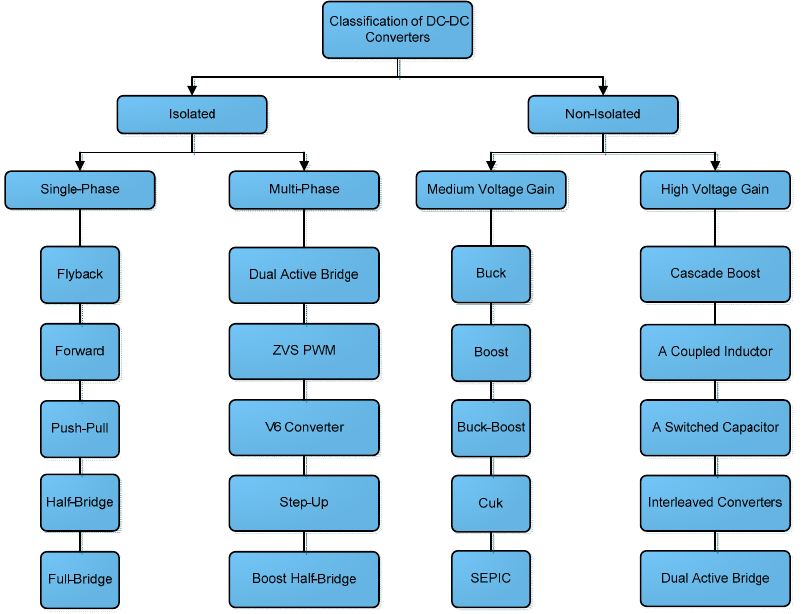
Figure 5. Isolated and non-isolated DC-DC converters.